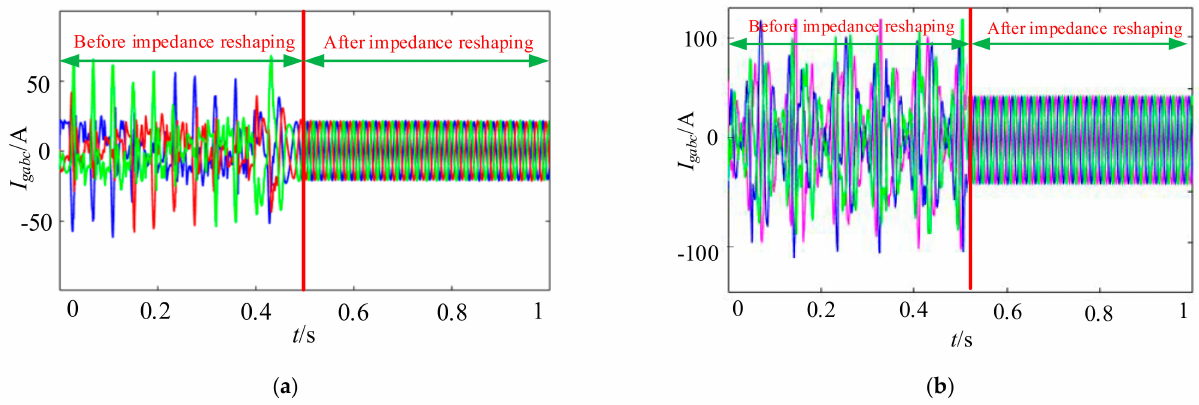
Figure 12. The grid-connected current waveform after the impedance reshaping. ( a ) P = 10 kW. ( b ) P = 20